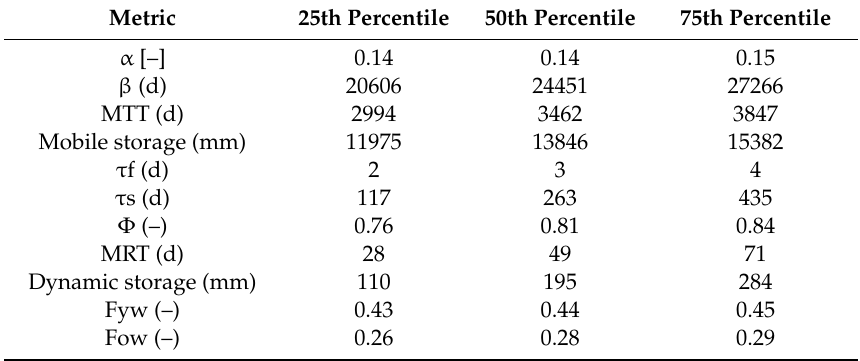
Table 2. Medians and interquartile ranges of two parallel linear reservoirs (TPLR) and gamma distribution (GM) parameters of best 100 TRANSEP